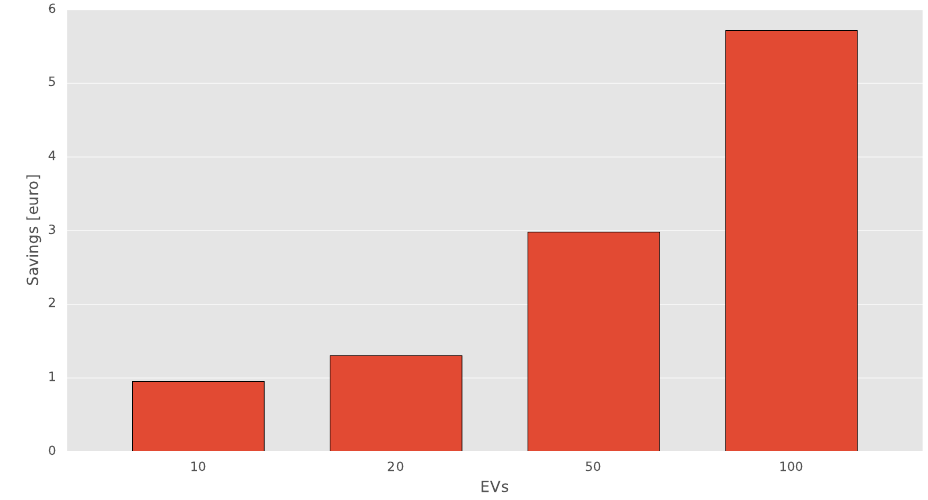
Figure 4. Average daily savings with the main scenario compared to the baseline scenario for a lead time of 2 intervals and a trading unit of 100kW.